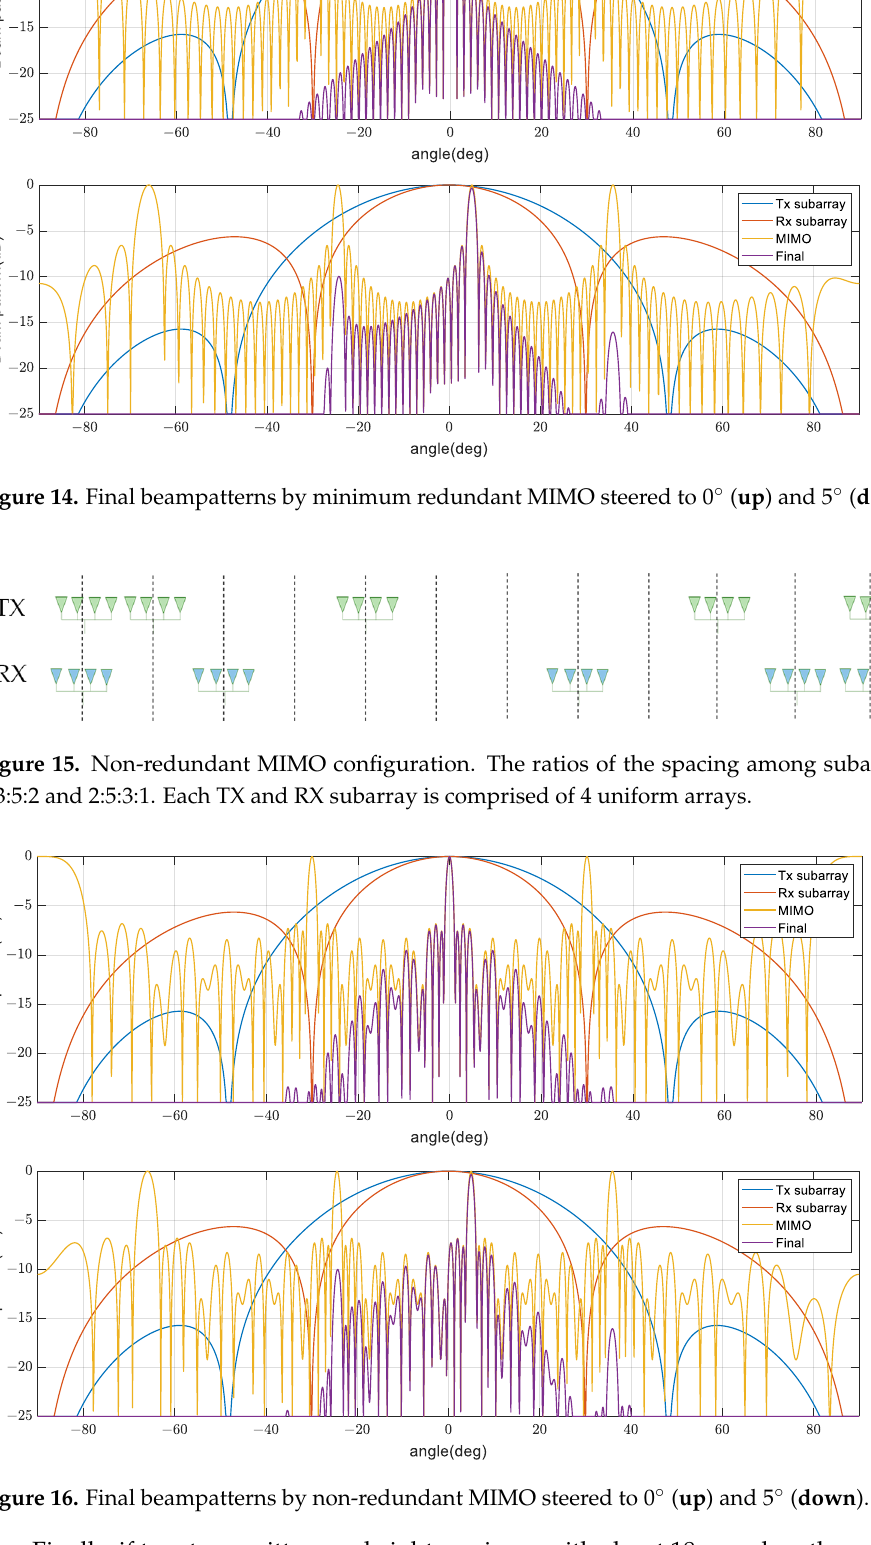
Figure 16. Final beampatterns by non-redundant MIMO steered to 0° ( up ) and 5° ( down ). Finally, if two transmitters and eight receivers with about 18 wavelengths are config- ured as shown in Figure 17, the final aperture becomes a uniform array of 36 wavelengths.